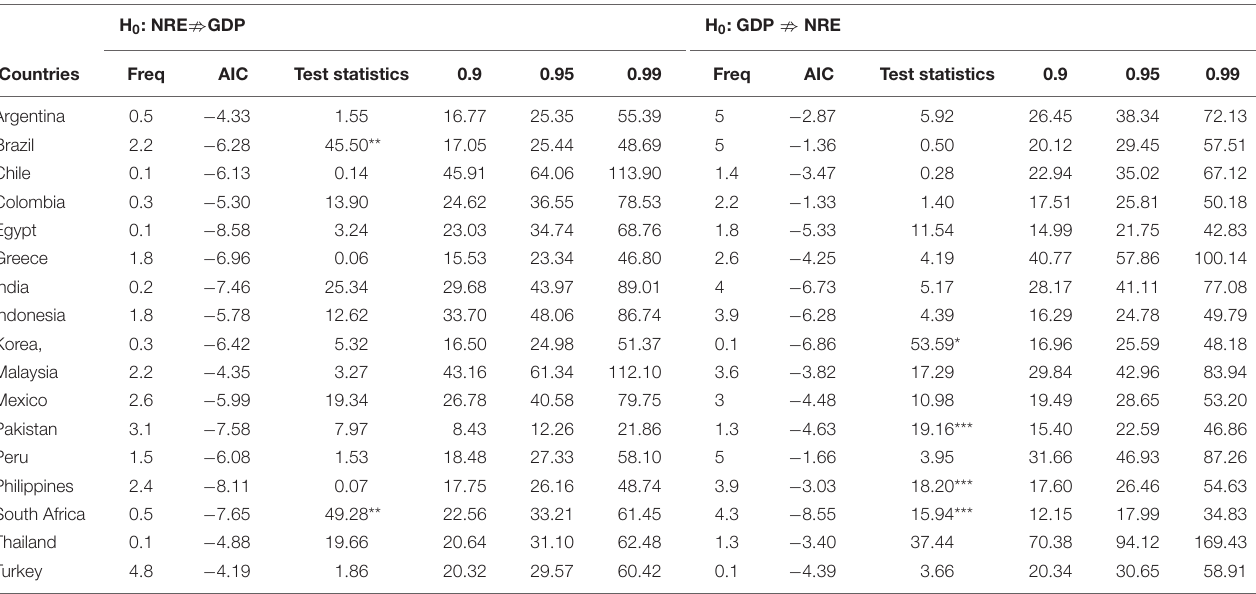
TABLE 6 | Fourier bootstrap panel causality test results for